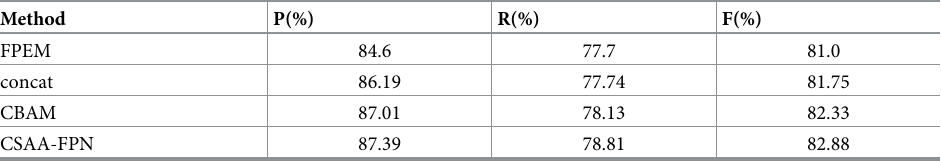
Table 3. The results of CSAA-FPN with different settings the CTW1500 dataset. “concat” means adding only multi- scale concatenation to the CSAA-FPN, and “CBAM” means adding only the attention mechanism to the CSAA-FPN.